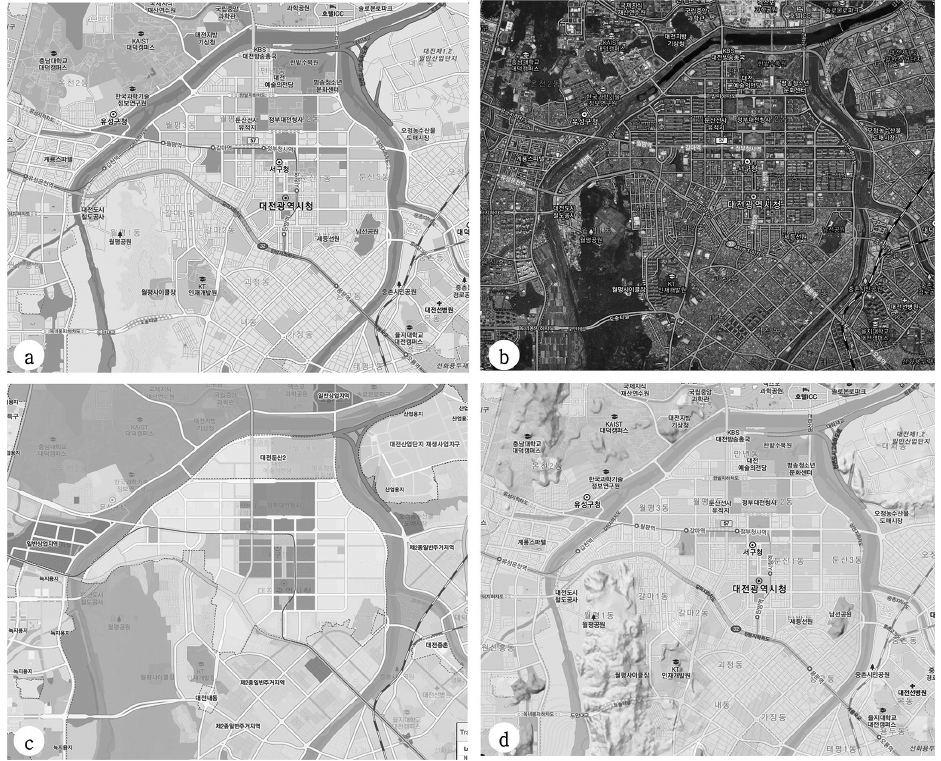
Figure 5. The resulted point locations or raster overlay of the real-time pollution attributes can be overlaid over four different maps of study area (a) vector map, (b) satellite view, (c) land use map and (d) terrain